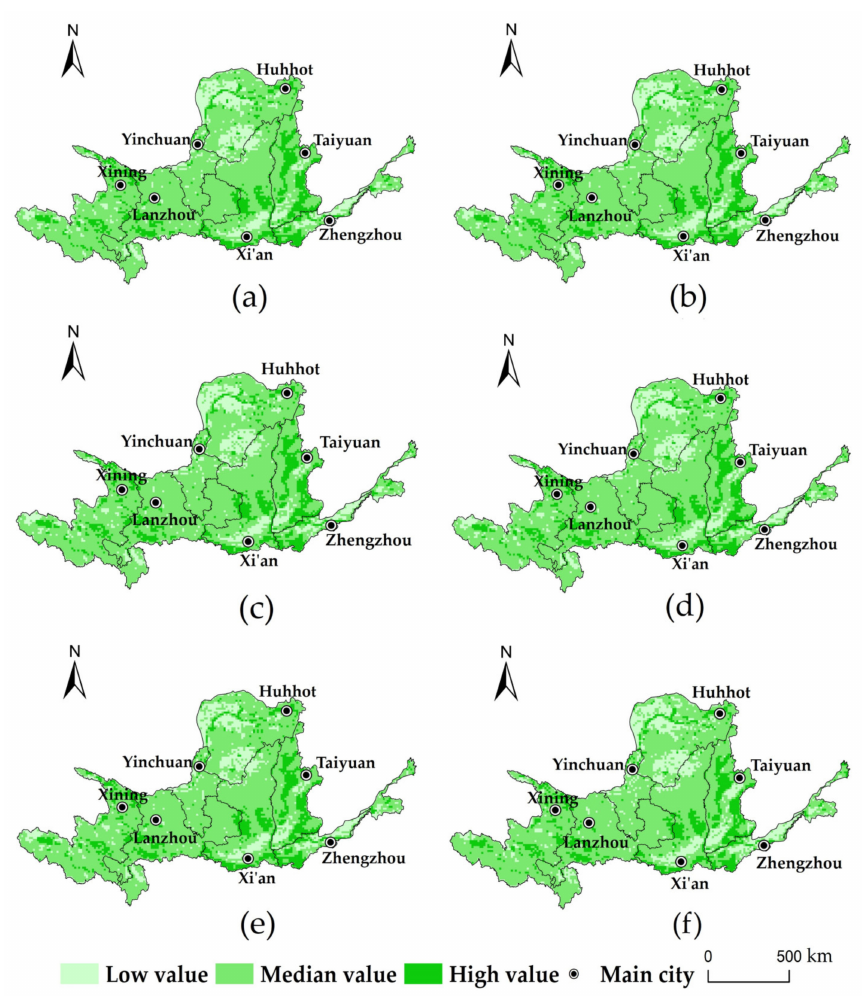
Figure 7. Spatial distribution of ecological benefits of land use in the Yellow River Basin: ( a ) 1995; ( b ) 2000; ( c ) 2005; ( d ) 2010; ( e ) 2015; ( f ) 2018. Using the Layer Stacking, the economic benefit, ecological benefit, and social benefit were respectively combined in the order of red, green, and blue in ENVI 5.3. And according to some basic rules of color superposition, for example, red and blue form purple, and the three colors of red, blue, and green are added to get black. Finally, this study got the following result figure (Figure 8). The result of Layer Stacking showed that the eastern and northern edge areas had bright purple or bright green, indicating that the economic, social, and ecological benefits of land use in these two areas were prominent. The central region had a large area of dark purple distribution, which showed that the economic and social benefit was more prominent than other regions. Green was widely distributed in the western region, which reflected the prominent ecological benefits. The distribution of the above colors further proved that high benefits were concentrated in the eastern and northern edge areas of the Yellow River Basin. At the same time, it reflected the poor coordination between the benefits of the two areas and the obvious polarization of the benefit distribution. Comparative analysis showed that the overall color in the basin became darker from 1995 to 2018, which meant that the polarization distribution among the benefits of land use was